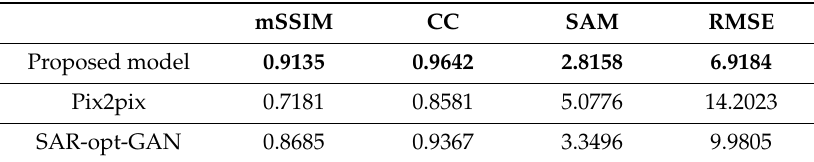
Figure 4. Results of each method in Dataset A. ( a ) original synthetic aperture radar (SAR) images; ( b ) simulated corrupted images; ( c ) results of the pix2pix model; ( d ) results of the SAR-opt- generative adversarial network (GAN) model; ( e ) results of the proposed model ( f ) ground truth. Table 1. Quantitative Evaluation of Models on Dataset